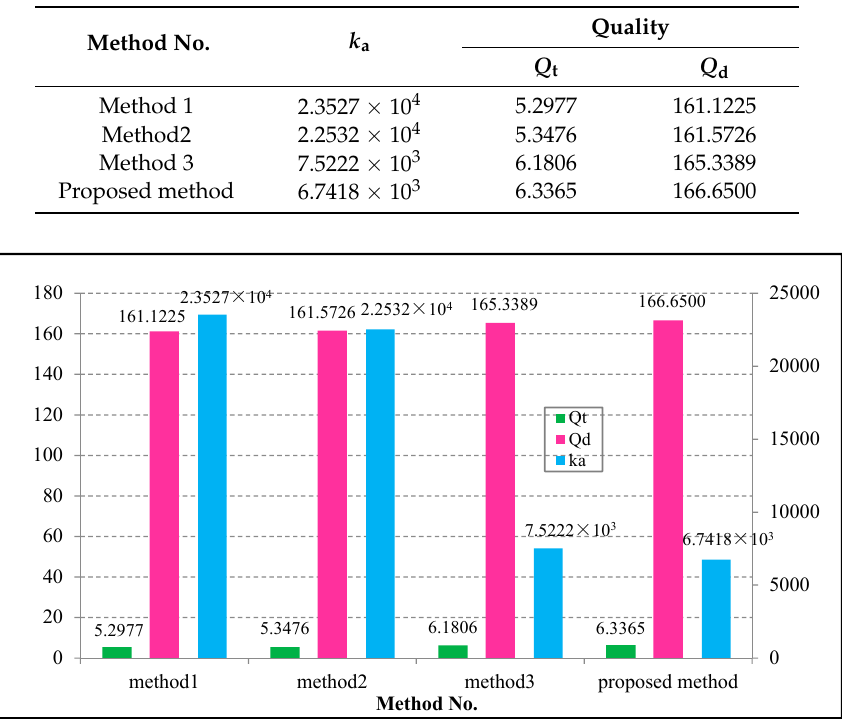
Figure 11. The condition number and quality of the four methods in 14 bus system.